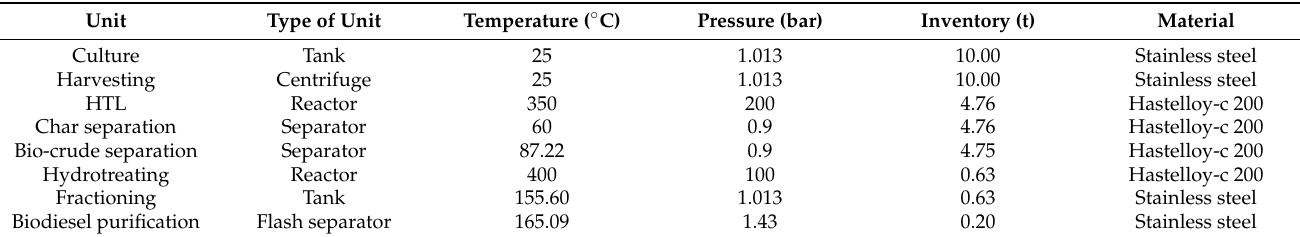
Table 6. Description of the main unit used for biodiesel production from microalgae via HTL.